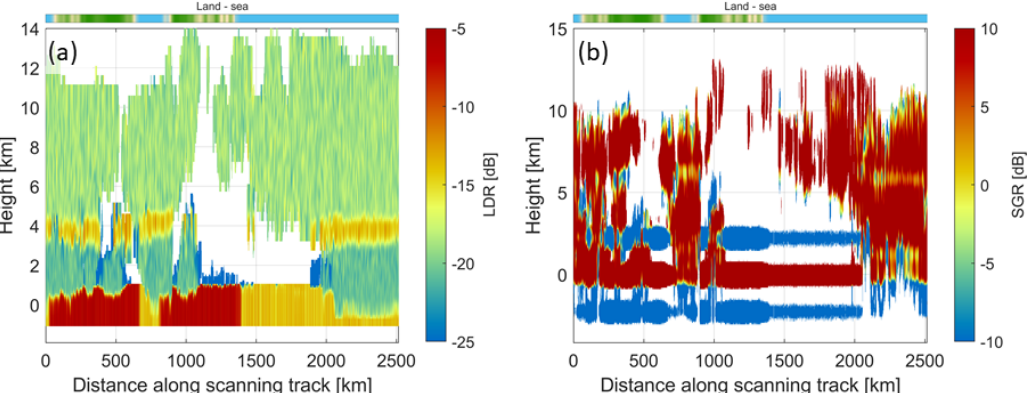
Figure 14. Linear depolarization ratio (LDR; a ) and signal to ghost (SGR; b ) in correspondence to the revolution shown in Fig. 9b as a function of height. The LDR clearly shows the significant depolarizations by the melting layer that is straddling the heights around 4km and by the surfaces with clear transitions from strong depolarizing land to weaker depolarizing sea surfaces. At ranges where ghost but no real clouds are present, the SGR becomes −∞ in logarithmic units (zero in linear units); thus, the SGR is capped at − 10dB. This is the case for several instances at a height of ± 2 . 3 (which corresponds to a slant range of 3km) in coincidence with surface cross-talk.